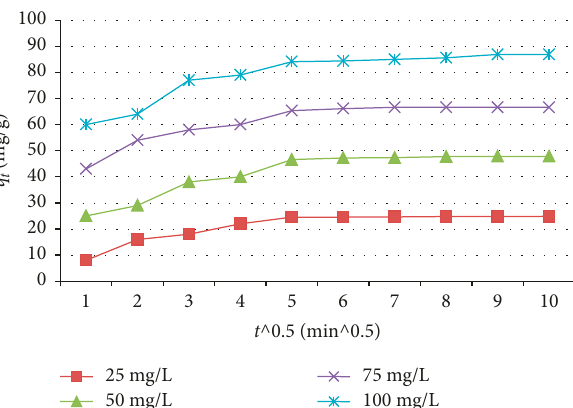
3, and sur- Figure 14: Intraparticle diffusion model for RB adsorption onto (cid:30) 60min, pH of the solution Fe 2 O 3 -13X-Ms. Time (cid:30) factant amount (cid:30)